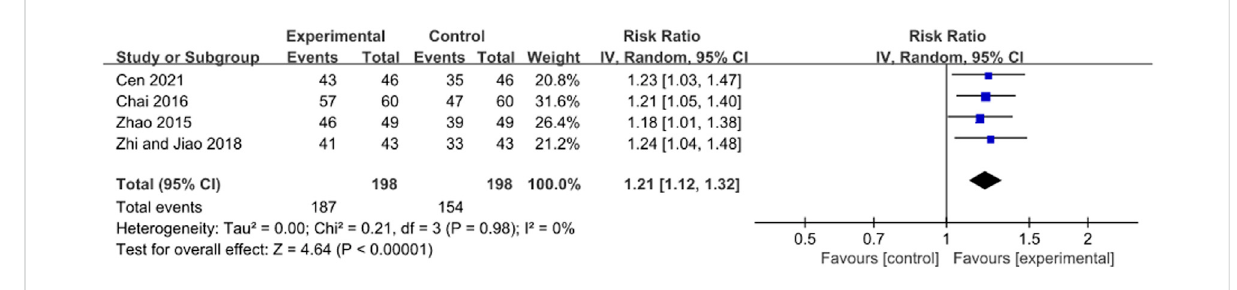
FIGURE 10 Forest plot of response rate after JWC with the duration of 2 weeks.